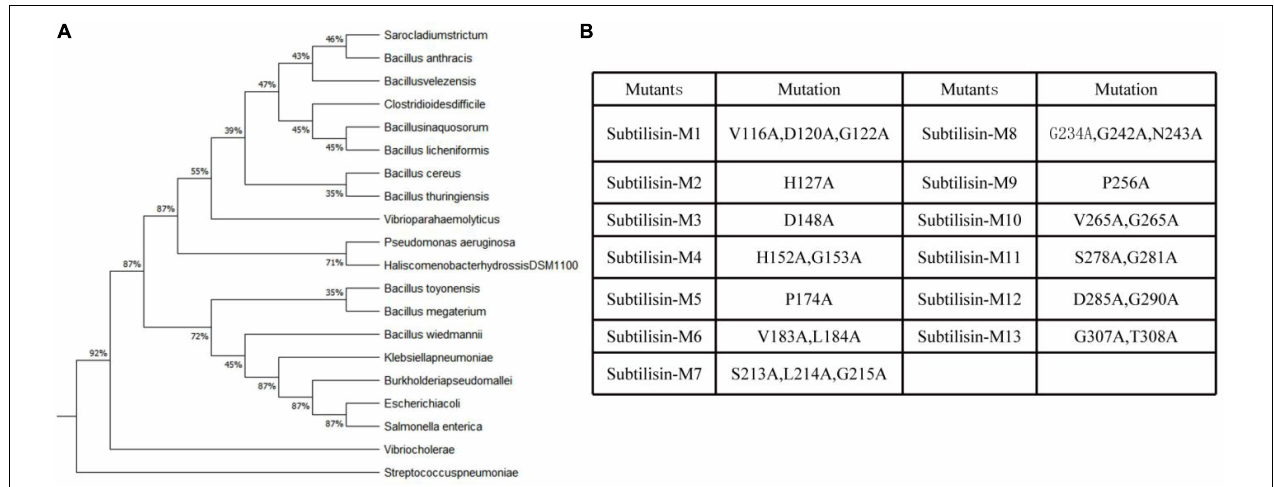
FIGURE 4 | Multiple sequence alignment of subtilisins. (A) Phylogenetic analysis of 20 subtilisin amino acid sequences after grouping. (B) Identification of conserved residues in subtilisin for point mutation analysis. List of point mutation sites for subtilisin in each subtilisin construct. All selected conserved sites of amino acids were mutated to alanine. Taking M1 as an example, 116V, 120D, and 122G were mutated to A and are thus noted as V116A, D120A, and G122A.